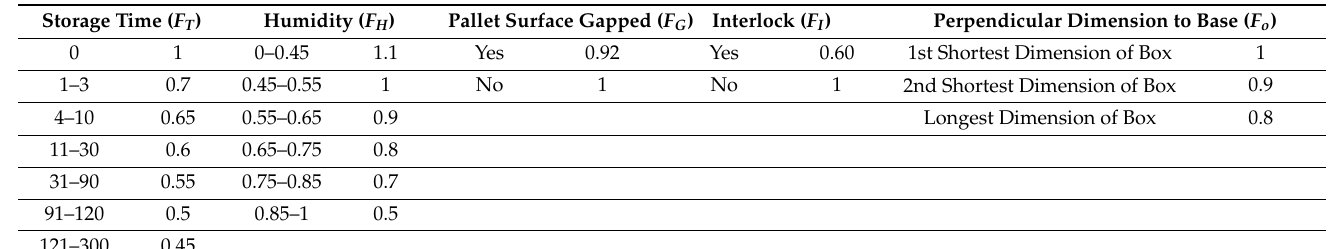
Table 1. Dynamic strength factors